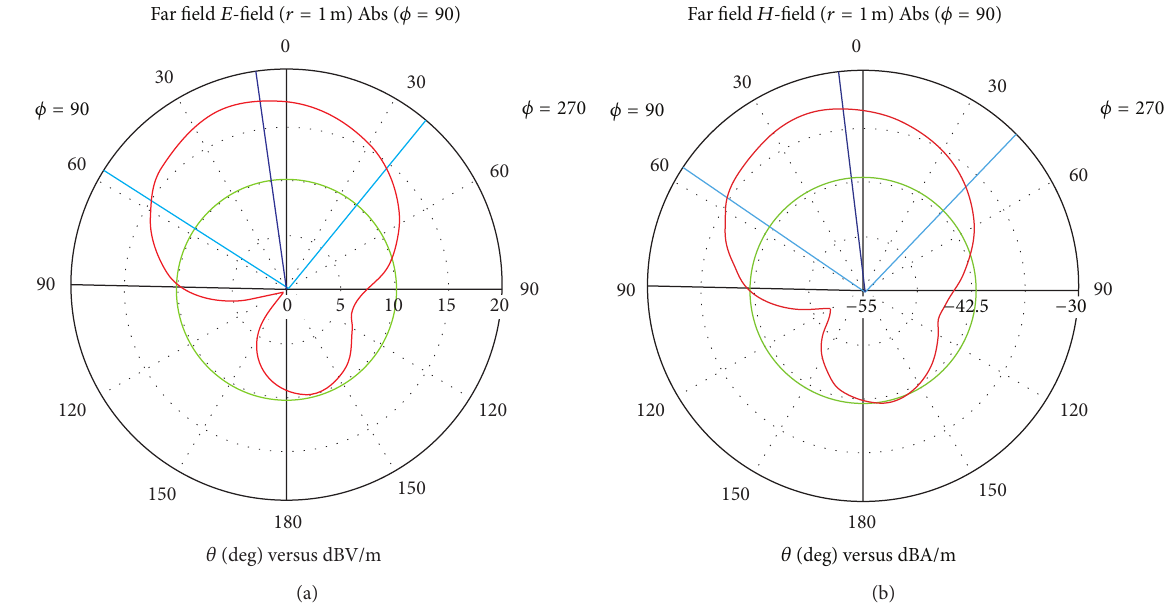
Figure 8: Conventional microstrip patch antenna. (a) E -field and (b) H -field.